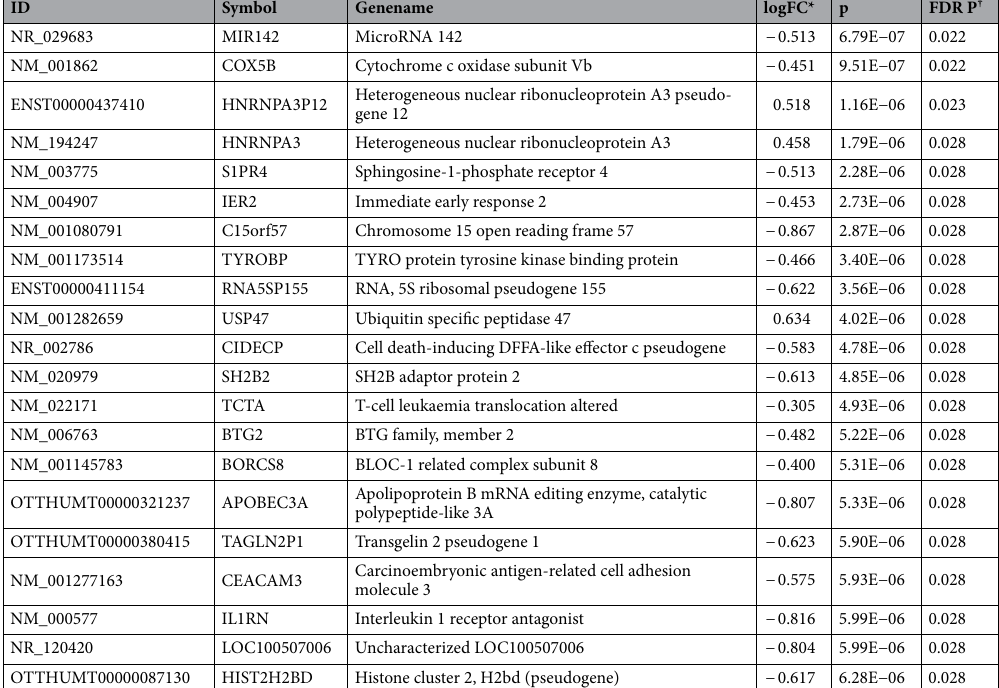
Table 1. Top 21 differentially expressed genes detected from PPROM versus HTERM expression analysis at week 20 of gestation. *logFC = log2 (fold change). † Significant at FDR p < 0.03, not including 3 unspliced